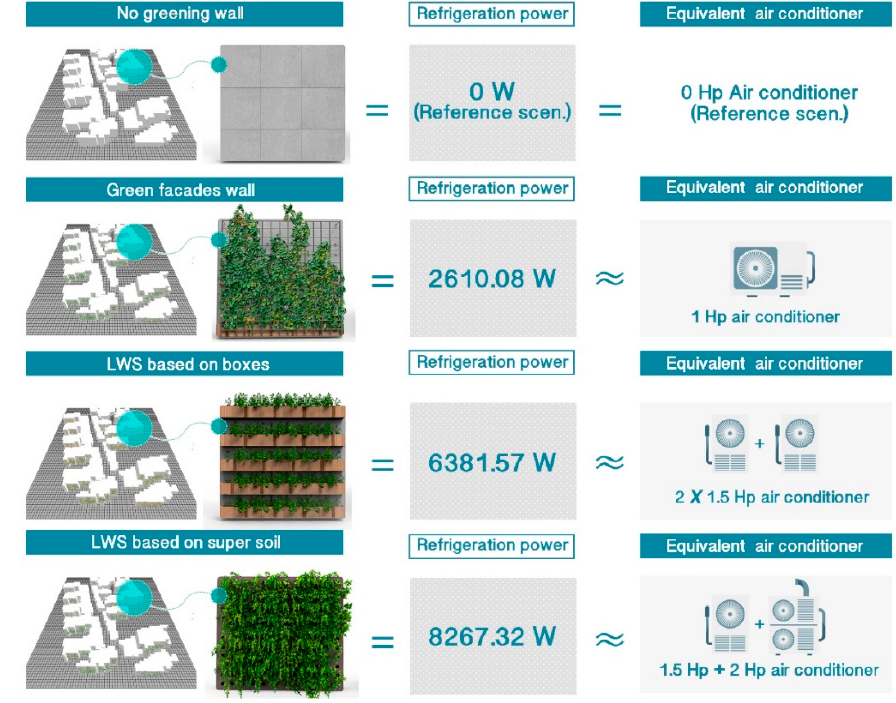
Figure 15. Refrigeration power of scenario 2 to